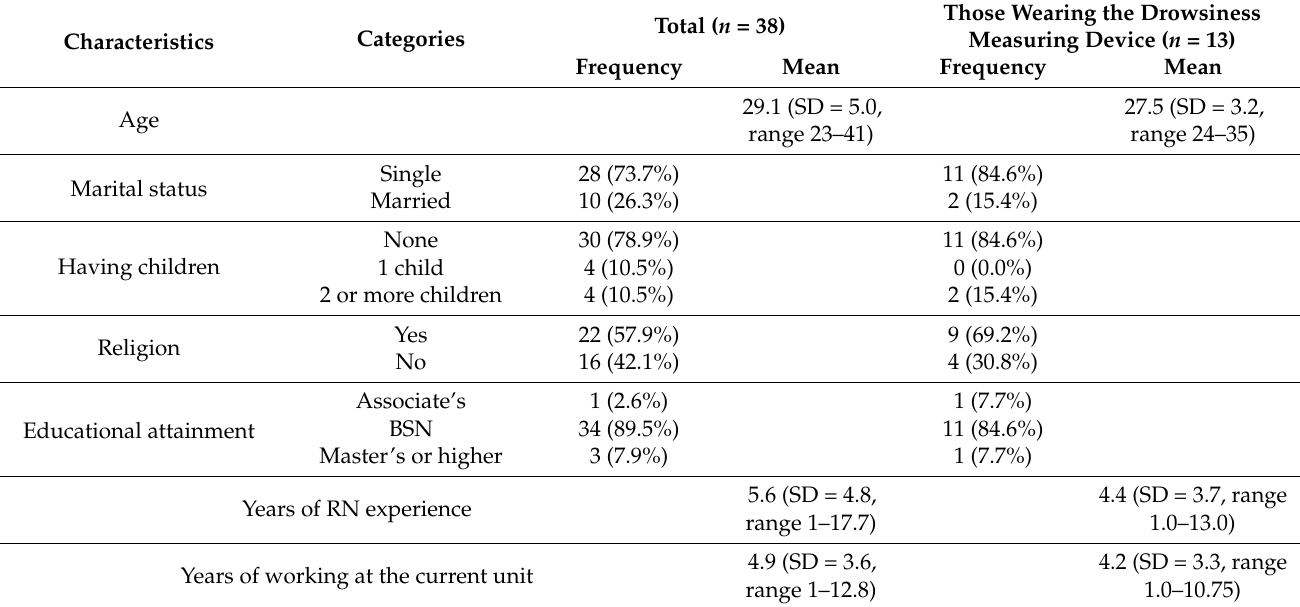
Table 1. Participant pretest characteristics ( n =